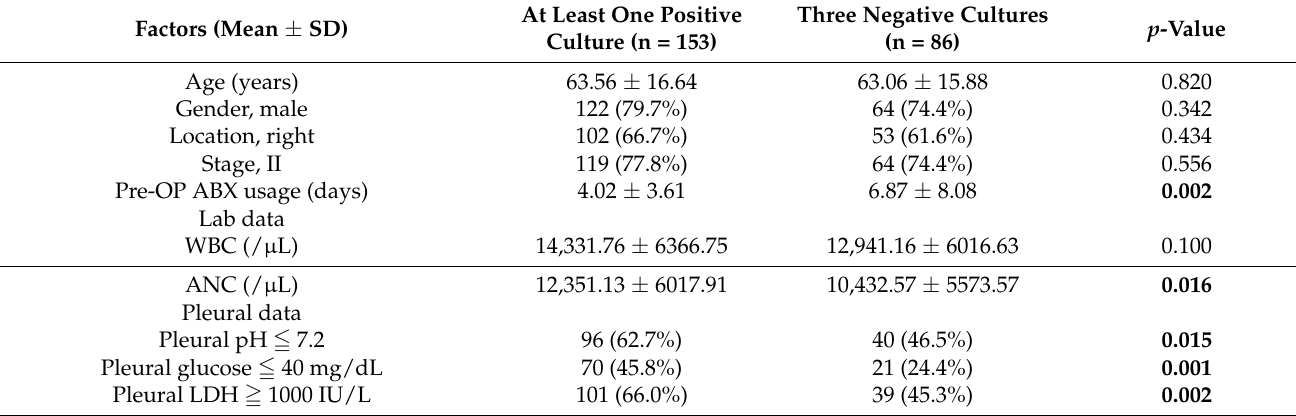
Table 2. Factors to predict the combined results of three types of cultures (pleural peels tissue, pleural fluid, and